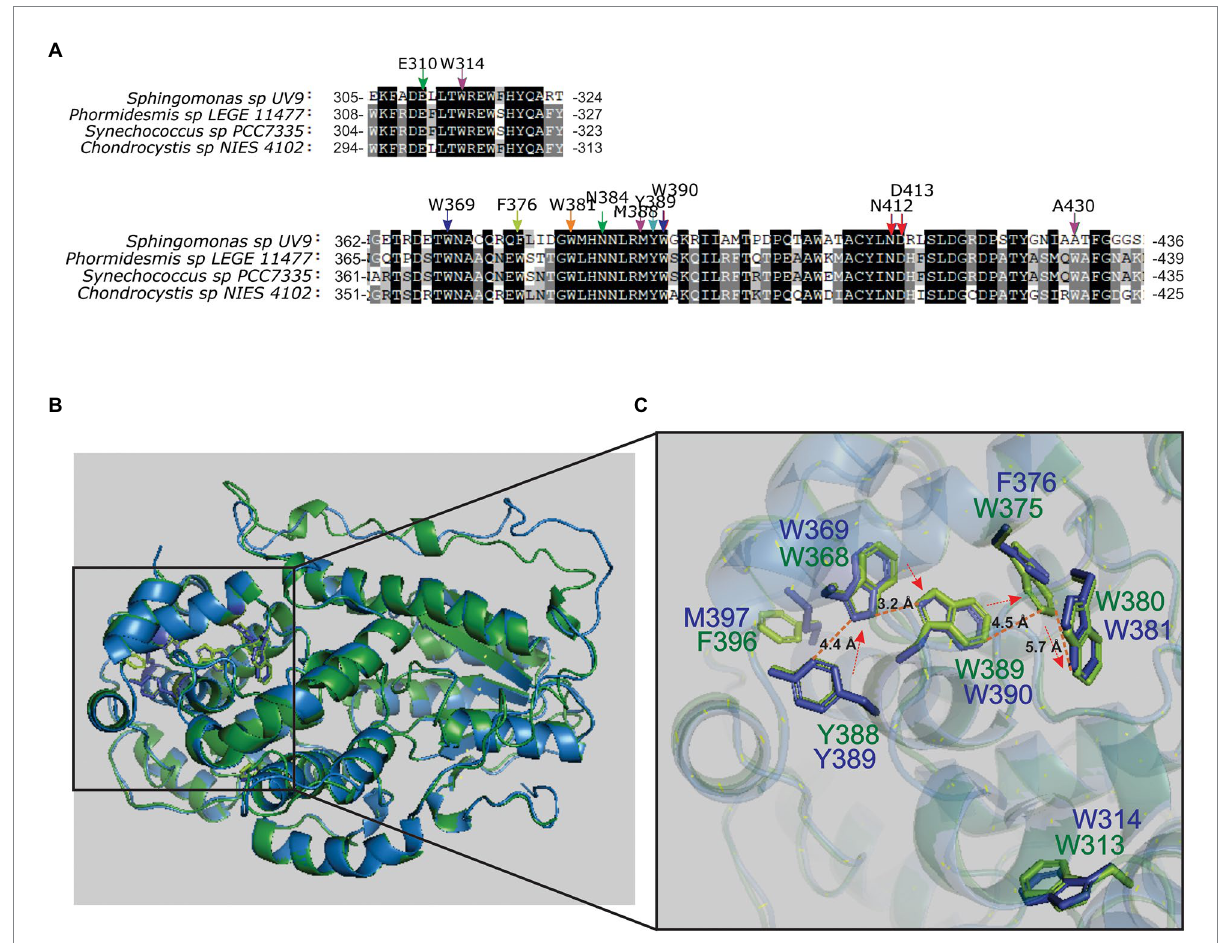
FIGURE 4 Multiple sequence alignment and molecular modeling in cyanobacteria. (A) MSA from PhrSph98 protein and cyanobacteria homologs was performed using MAFFT software. Arrows indicate conserved amino acids involved in electron transfer pathway (in the same colors as phylogeny rings from Figure 1), FAD cofactor binding (red), DNA lesion binding (purple) and lesion stabilization (green). Conserved residues common to all sequences are shadowed in black and less identity is shown in gray scale. Full MSA is presented in Supplementary Figure S2. (B) Superposition of predicted crystal tertiary structures from PhrSph98 (blue) and Synechococcus sp. PCC 7335 bifunctional CPD/(6-4) photolyase- like protein (green). (C) Amplification of catalytic domain. Amino acids described that may be involved in electron pathway in PhrSph98 are shown in blue Y389-W369-W390-F376-W381. Homologs from Synechococcus sp. PCC 7335 bifunctional CPD/(6-4) PHR- like protein are shown in green. The arrows indicate the electron flux direction. Dash lines indicate distances in amstrongs (Å) among atoms. (B) and (C) were generated by using